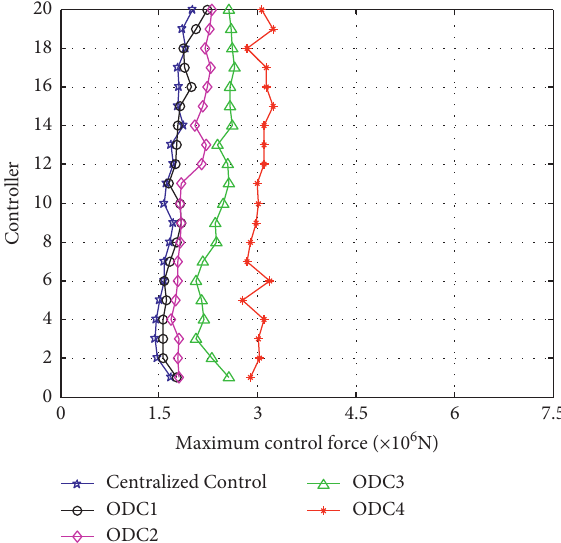
Figure 10: The maximum control force of time delay τ �